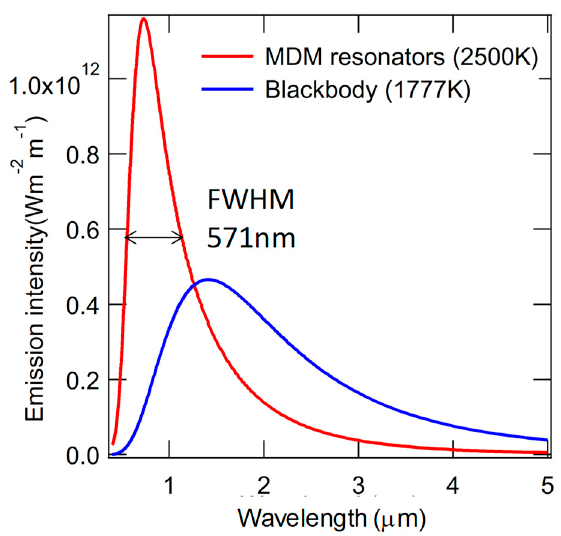
Figure 10. Simulated thermal radiation spectra in constant power mode: radiation spectra from the MDM metasurface (red line) composed of HfN and HfO 2 at T = 2500 K with d = 40 nm, P = 80 nm, T g = 60 nm, T d = 20 nm, and the reference blackbody (blue line) at T = 1777 K.